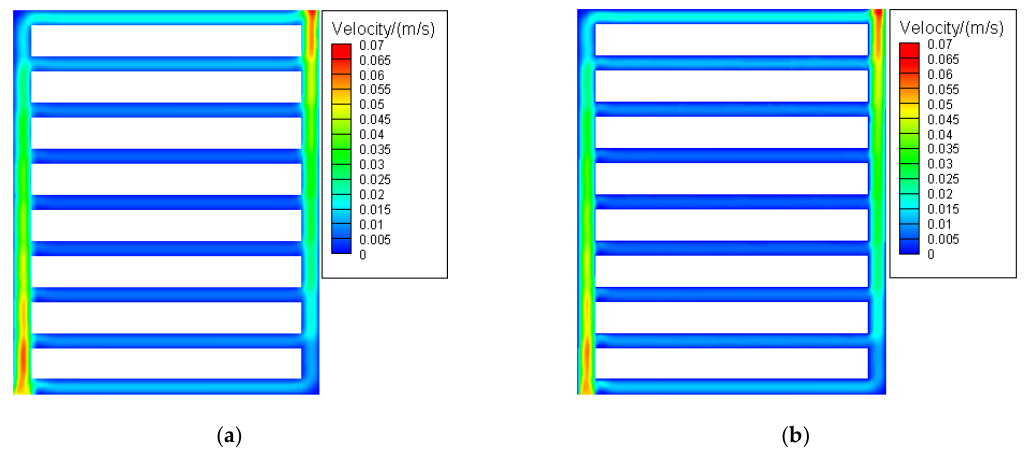
Figure 3. Velocity distribution contour: ( a ) calculation result by Fluent; and ( b ) Calculation result by dimensionless LSFEM.